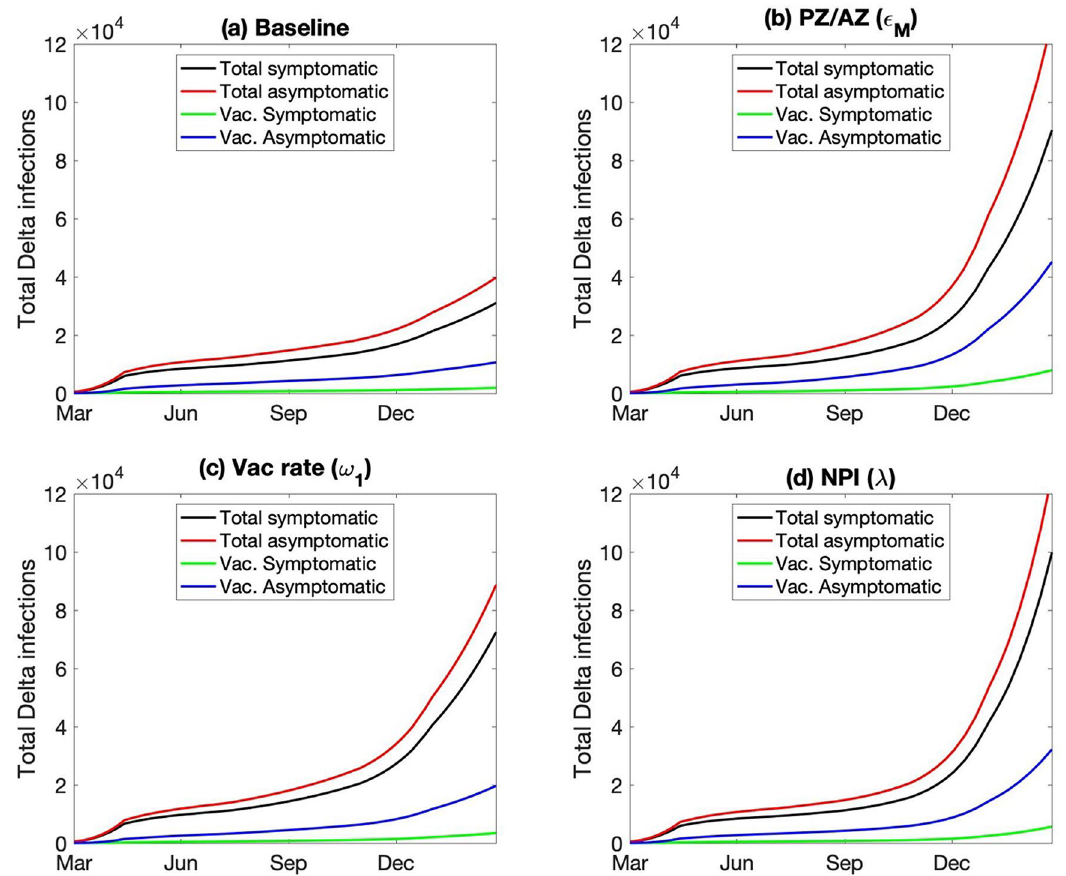
Figure 8. Number of different types of Delta infections: total symptomatic and asymptomatic infections, and those of vaccinated individuals. In all four scenarios, asymptomatic patients and vaccinated patients account for a significant fraction of the disease